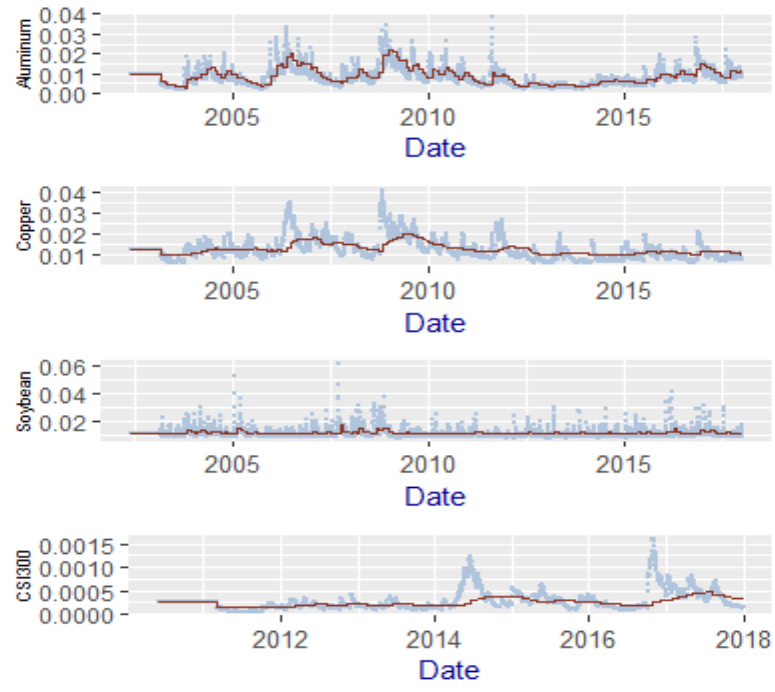
Figure 4. The conditional variance and its secular component of a futures contract.